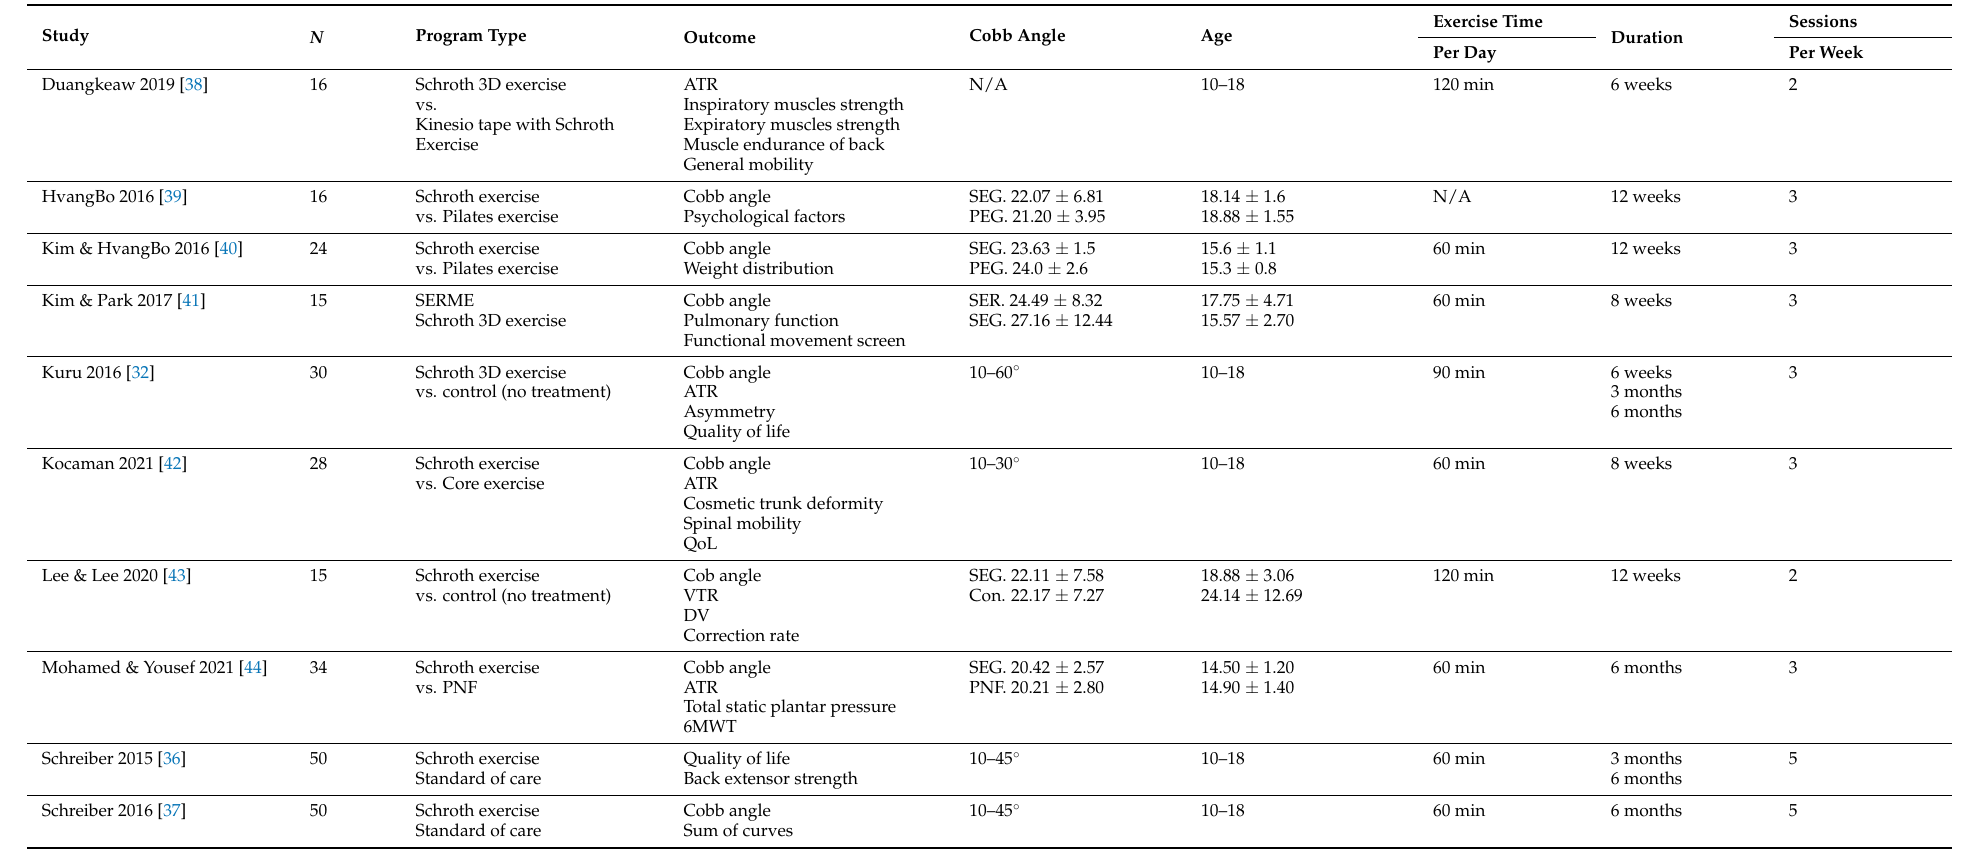
Table 1. Description of the